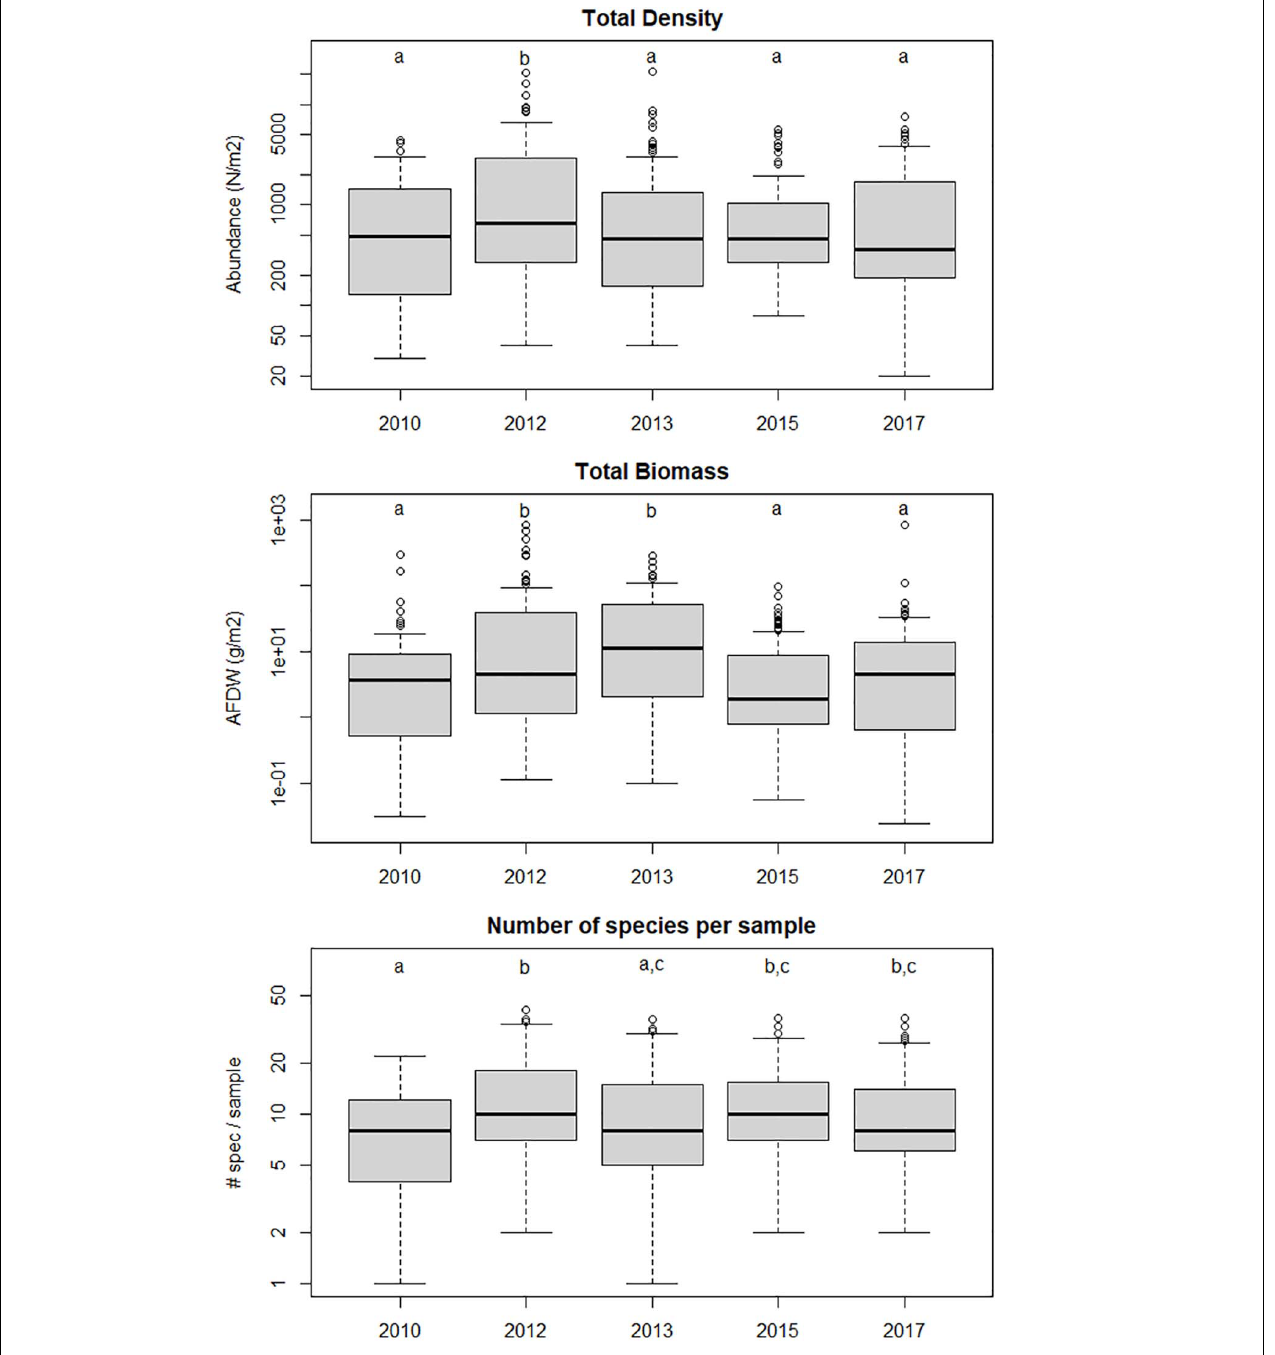
FIGURE 2 | Total density, total biomass and number of species per sample in the different years. Years sharing the same letter are not significantly different ( p < 0.05) from one another in a Tukey post-hoc test. 2010 shows the situation before the Sand Motor, the other years show the evolution of the area after the construction of the Sand